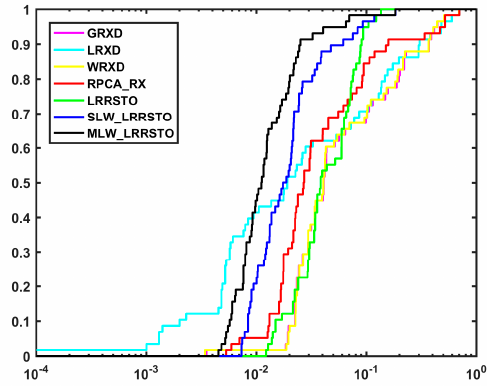
Figure 10. ROC evaluation of the different methods for the AVIRIS_SanDiego dataset. Table 5. AUC values for the different detectors with the AVIRIS_SanDiego dataset.